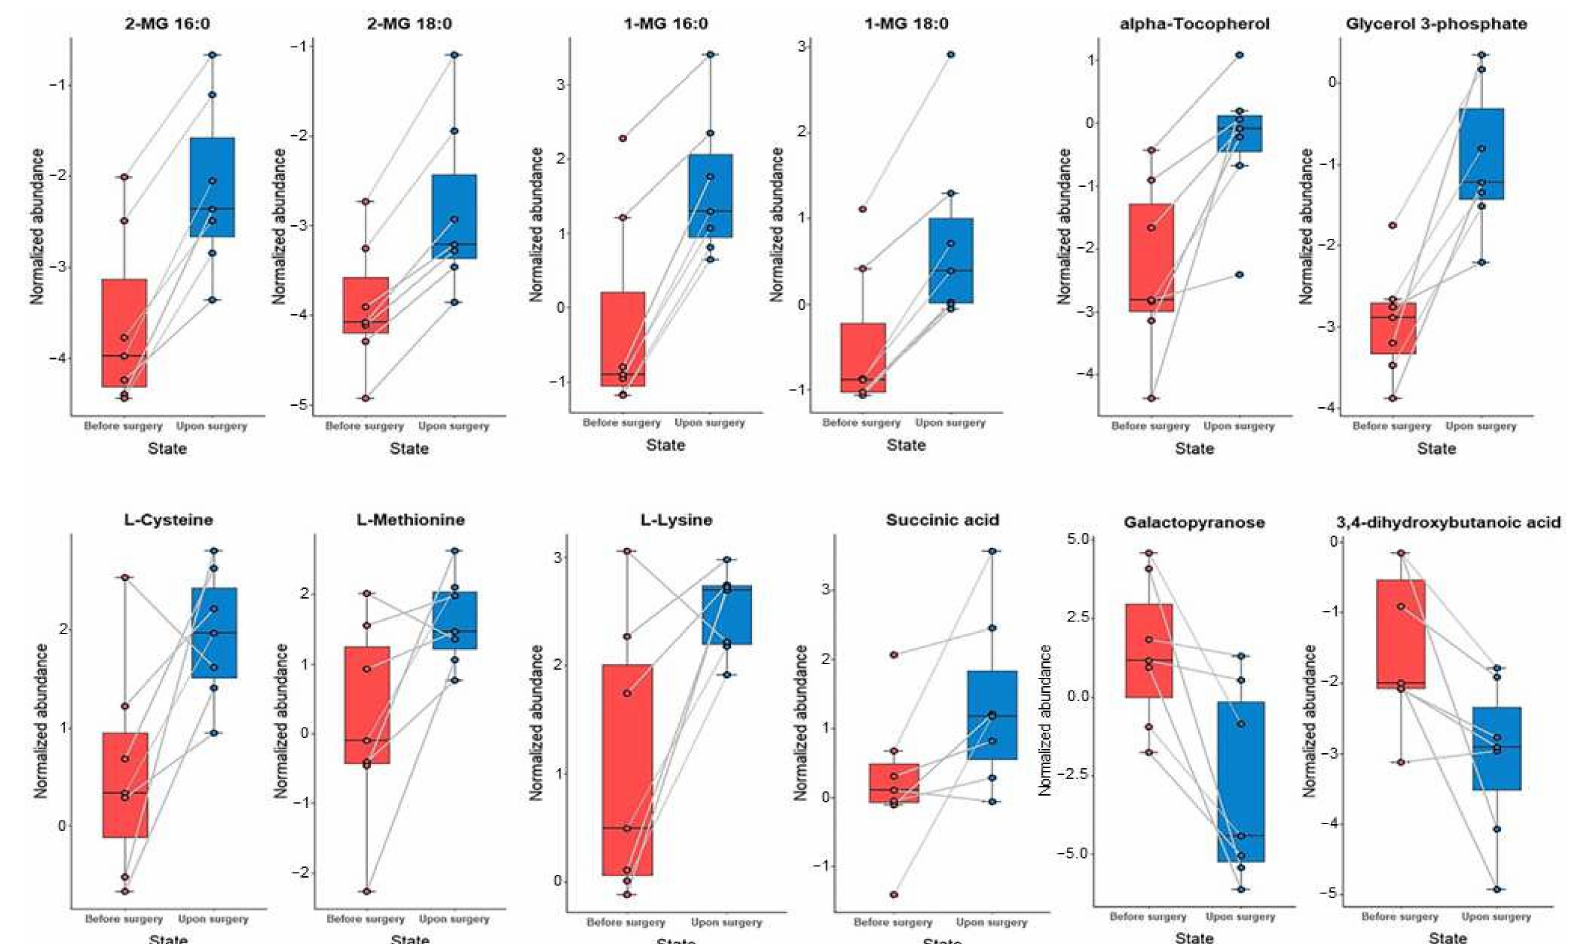
Figure 1. Box plots illustrating changes in levels of selected metabolites before and after the